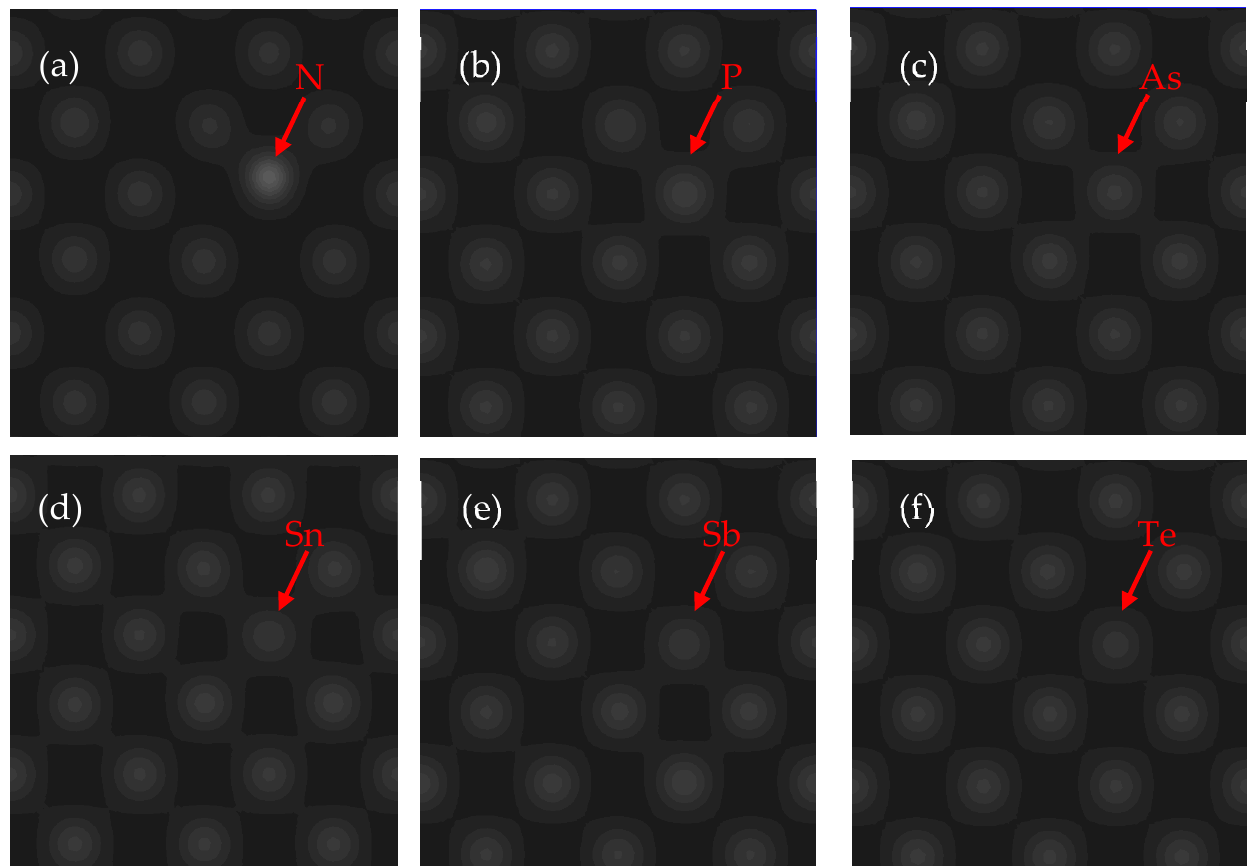
Figure 5. The slicing plane (parallel to the sheet of 2D material) of the charge density difference for the doped models of GeSe_N ( a ), GeSe_P ( b ), GeSe_As ( c ), GeSe_Sn ( d ), GeSe_Sb ( e ), and GeSe_Te ( f ).